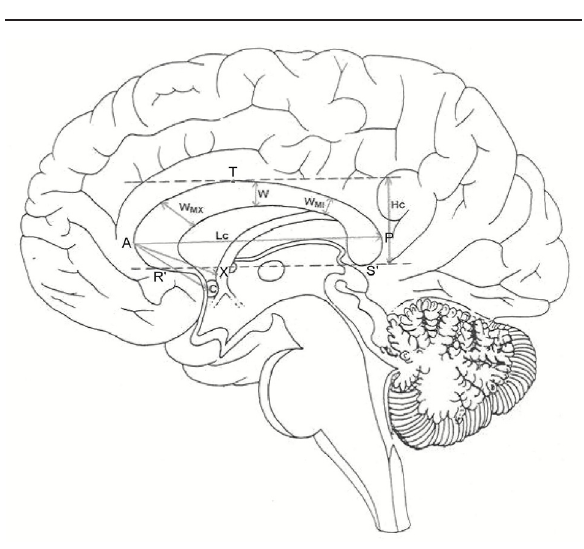
figure 3. Measurements of corpus callosum (I).